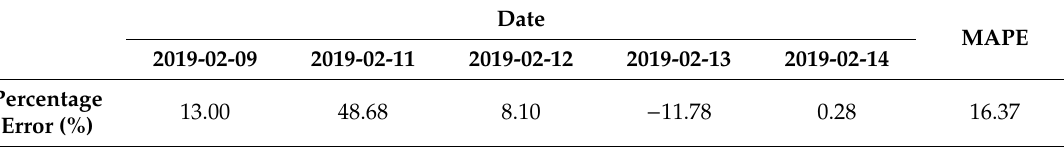
Figure 15. Ore-production inference during morning operation (tons) obtained through the multiple regression analysis. Table 12. Prediction error between predicted and actual morning ore productions during five working days.